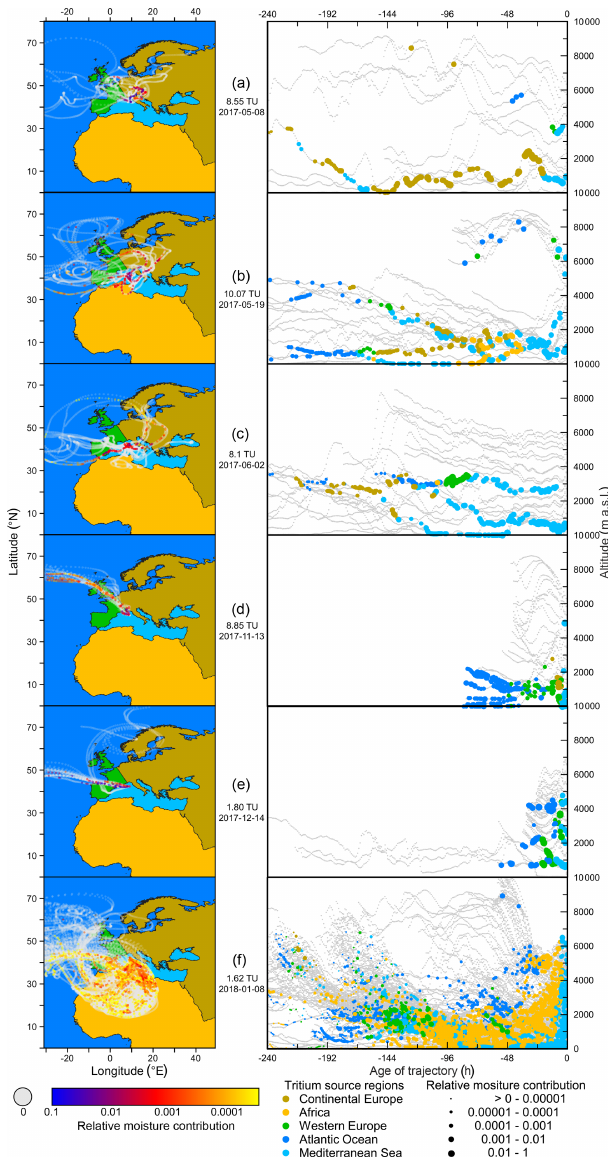
Figure 7. Maps and vertical cross sections of air mass trajectories for outlier events based on 10d trajectories. For the definition of extreme events, the reader is referred to Sect. 4.3. Map background colors and cross section trajectory point colors refer to the assumed tritium source regions (cf. Fig. 2). Colors of map trajectory points and the size of cross section trajectory points correspond to the rel- ative moisture contribution to the precipitation event (cf. Fig.